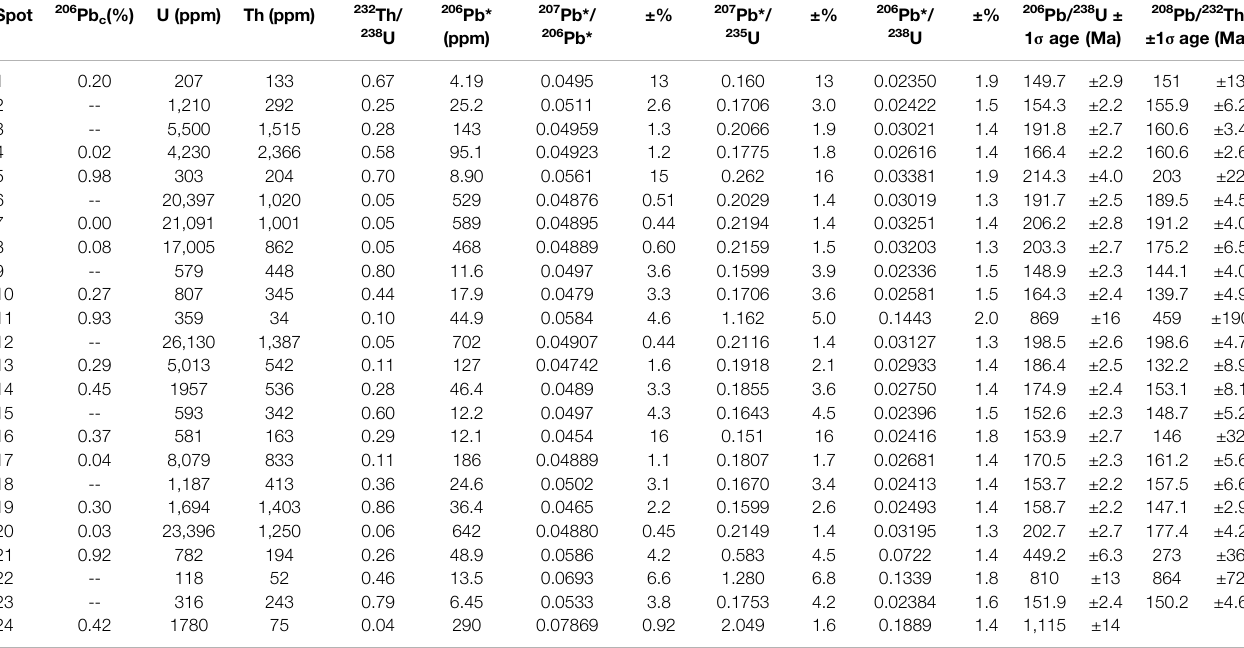
TABLE 2 | SHRIMP Zircon U-Pb data of the granitic porphyry dyke (Sample 1717) related to Yinbeidong Kaolin deposit. Spot 206 Pb c (%) U (ppm) Th (ppm)